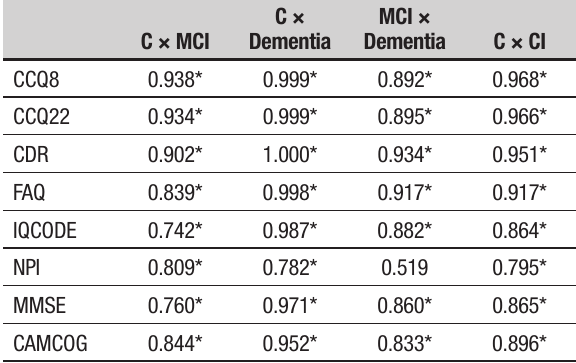
Table 5. Area under the ROC curve (AUC) for all tests among groups. C ×